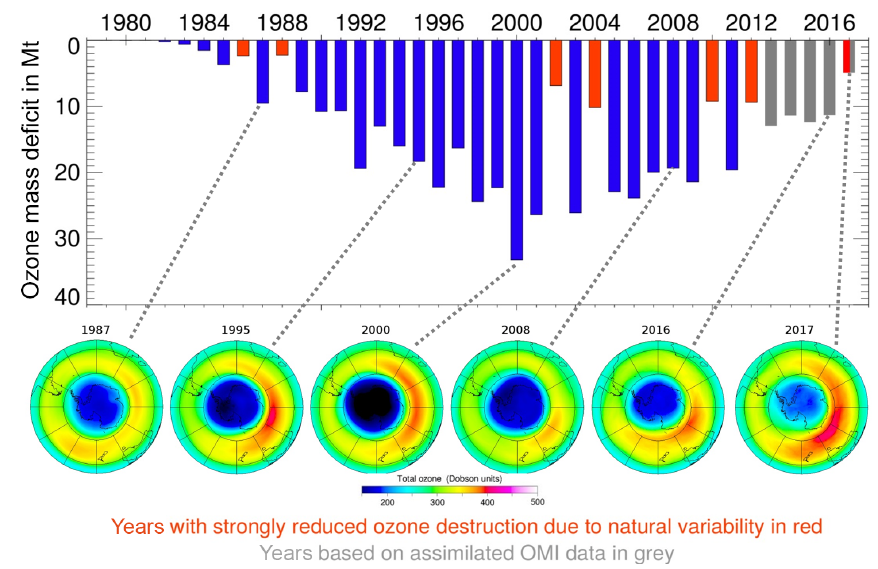
Figure 13. Annual September average daily ozone mass deficit (OMD) over Antarctic relative to the 220DU total ozone column level, the most common total ozone column threshold value for calculating the OMD (see Sect. 6.1 for an explanation of OMD).